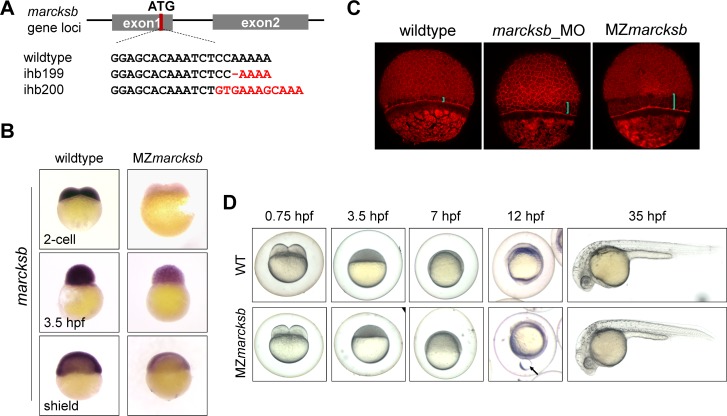
MZmarcksb do not show visible dorsoventral defects.(A) The diagram shows the gRNA target of marcksb genome locus and the genotypes of two individual marcksb mutants generated by CRISPR/Cas9. (B) The transcription level of marcksb was significantly decreased in MZmarcksb embryos. Embryos of 2-cell stage, high stage and shield stage were present. All the embryos were lateral view with animal-pole to the top. (C) Both MZmarcksb and marcksb morphants showed similar defect of epiboly movement. The blue bar indicates the distance between the inner layer of cells and the envelope layer. (D) The wildtype and MZmarcksb embryos at developmental stages of 0.75 hpf, 3.5 hpf, 7 hpf, 12 hpf and 35hpf. MZmarcksb showed yolk bulge phenotype during early somite stage but normal appearance of development at 35 hpf. “Arrow” indicates the extrusion of the vegetal-most part of the yolk.